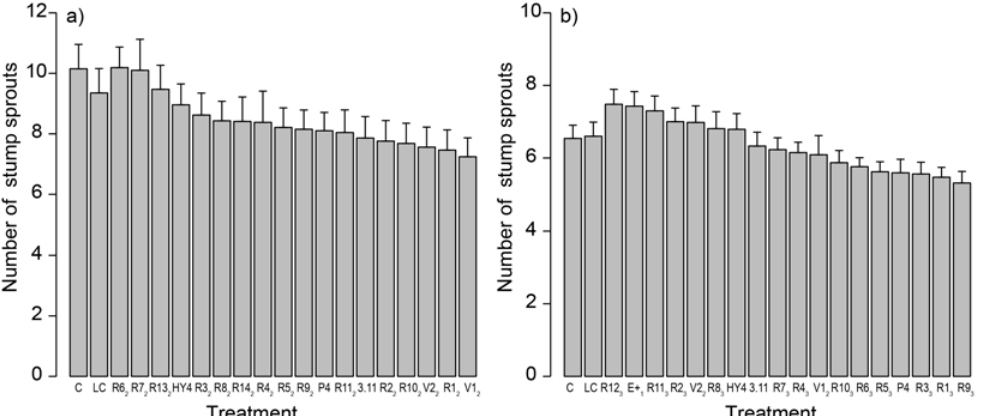
Fig 2. The Effects of Different Treatments on Birch Spouting during Phases 2 and 3. The number of stump sprouts of birch ( Betula pendula and B . pubescens ) per investigated stump one growing season after the treatments a) in Phase 2 (Porvoo in 2009) and b) Phase 3 (Turenki in 2010). C = control, i. e., cutting only; LC = liquid control, i.e., cut stumps were spread with the inoculum medium without C . purpureum ; HY4, P4 and 3.11 = the best parental strains of C . purpureum ; E+ 1 , R1 2 -R11 2 , R13 2 -R14 2 , V1 2 -V2 2 , and R1 3 -R12 3 = progenies of C . purpureum strains, see Table 2. Means with standard errors are